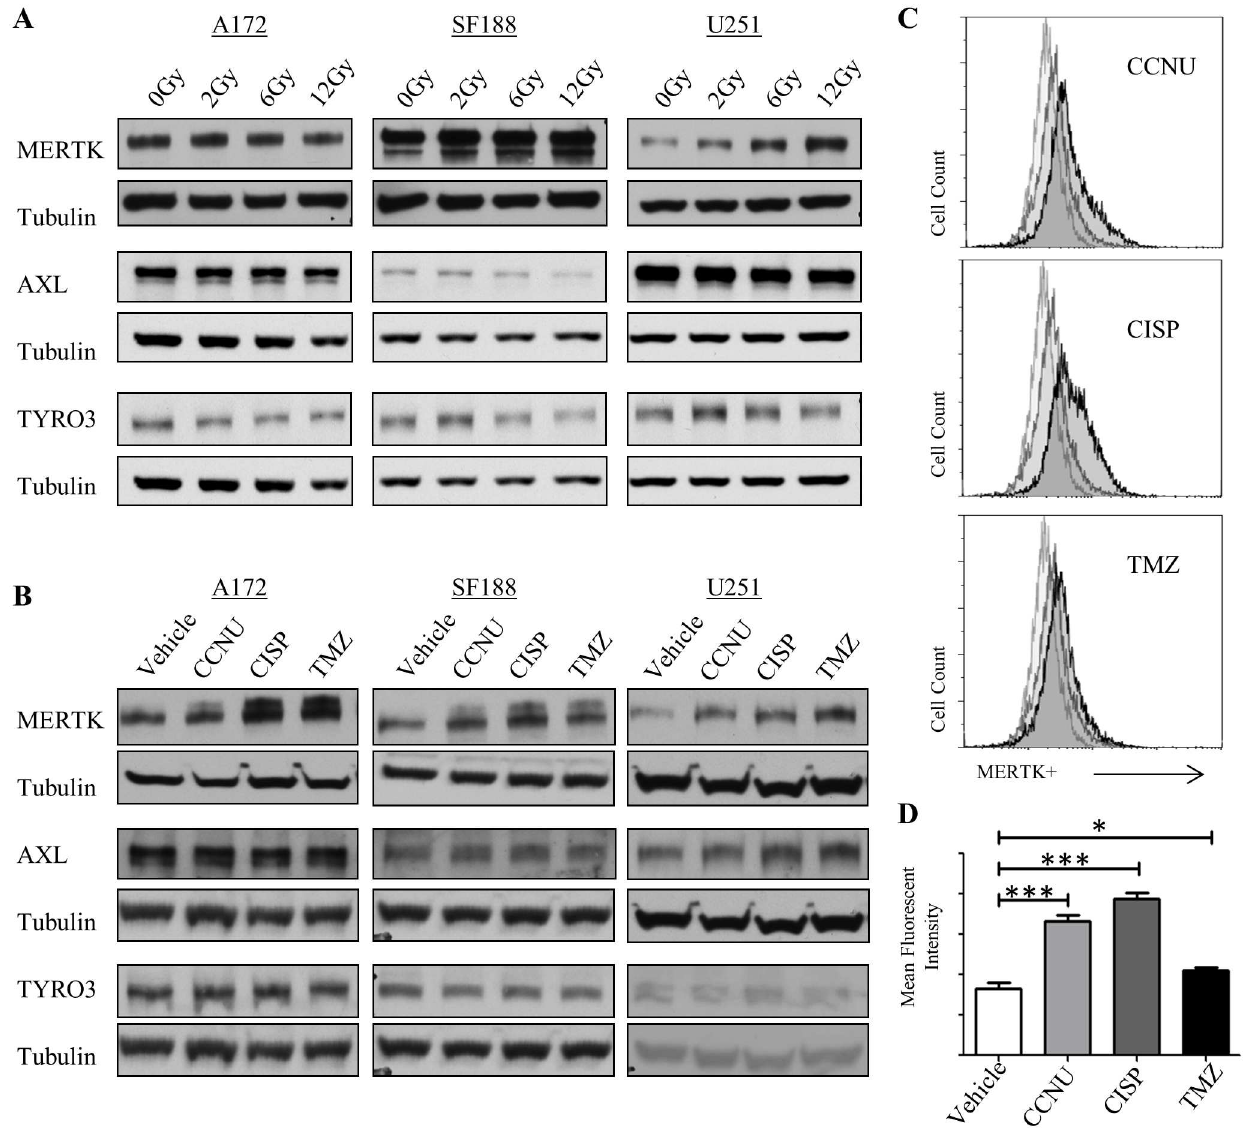
Fig 6. MerTK expression is increased in GBM cells after treatment with radiation and chemotherapy. A172, SF188, and U251 cells were exposed to 50uM lomustine (CCNU), 25uM Cisplatin(CISP), or 250uM Temozolomide(TMZ) (A) or radiation (0Gy, 2Gy, 6Gy, 12Gy) (B) for 48 hours and MERTK, AXL, TYRO3 and tubulin were detected in cell lysates by immunoblot. Representative images from three independent experiments are shown. (C-D) SF188 cells were treated with 50uM lomustine (CCNU), 25uM Cisplatin (CISP), or 250uM Temozolomide (TMZ) as describedabove and MERTK expression was determined by flow cytometry (colors on the flow cytometry graph; light grey = secondary only; grey = control; black = treatment). Representative images (C) and mean fluorescence intensities (+/- standard error) (D) from 2–4 independent experiments are shown. ( * p < 0.5, ** p < 0.01, *** p < 0.001,